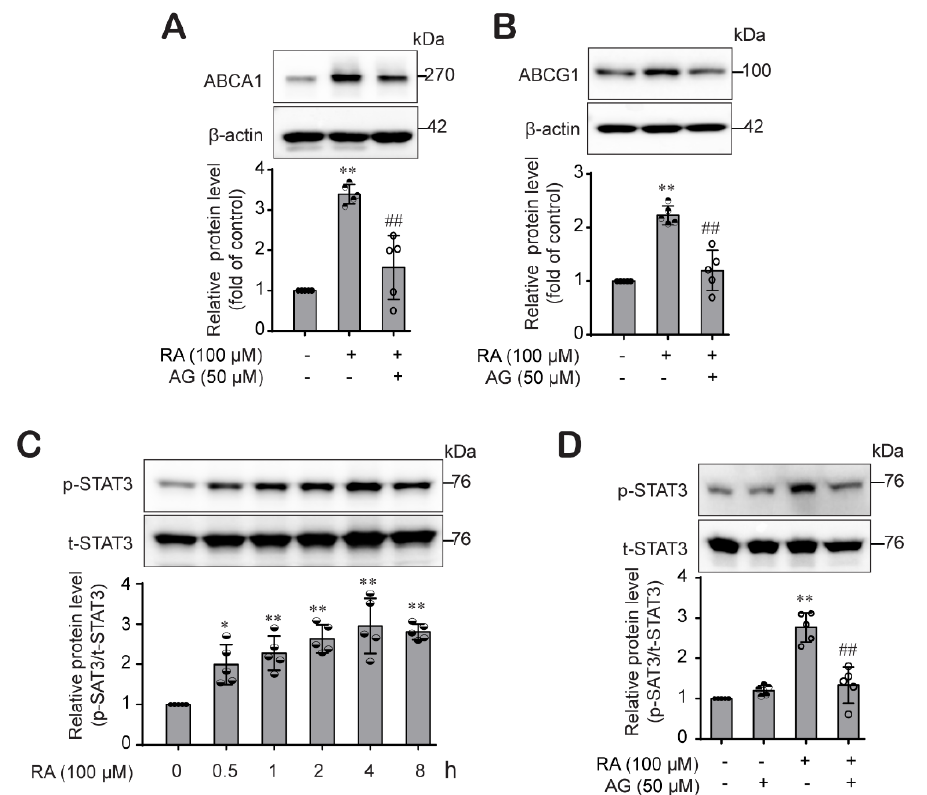
Figure 3. RA increased ABCA1 and ABCG1 protein expression through the JAK/STAT3 signaling pathway in THP-1 macrophages. ( A , B ) THP-1 macrophages were pretreated with AG490 (a JAK2 inhibitor, 50 μ M) for 1 h and then treated with RA (100 μ M) for 24 h. ABCA1 ( A ) and ABCG1 ( B ) protein levels were analyzed by western blot analysis. Band densities were quantified, and relative protein levels are presented as the mean ± SD of five independent experiments. ( C ) THP-1 macrophages were treated with RA (100 μ M) for various time durations, after which phospho-STAT3 protein levels were determined by western blotting. ( D ) Cells were pretreated with AG490 (50 μ M) for 1 h and then treated with RA (100 μ M) for 4 h. The phospho-STAT3 protein levels were determined by western blotting. The data are presented as the mean ± SD of five independent experiments. * p < 0.05, ** p < 0.01 compared to the control; ## p < 0.01 compared to the RA-treated group.